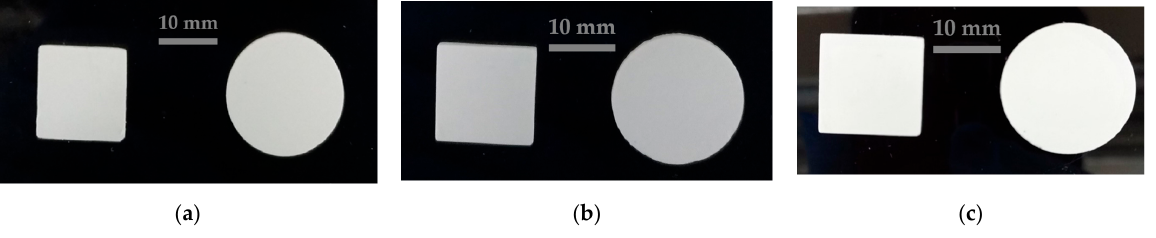
Figure 12. DLP printed part with 25 µm as layer thickness, 50‰ s exposure time, and exposure time of ( a ) 1 s; ( b ) 2 s; ( c ) 3 s, same as Figure 11a. For the discs and plates with layer thicknesses of 50 µm and 100 µm, the samples that were tried to be produced at the lowest level of power and exposure time failed, as the energy input was probably not sufficient for guaranteeing enough light penetration to stick two consecutive layers in a stable way. Other conditions were all printed with dif- ferent outcomes. Since the energy delivered to the layer in the same printing conditions, in terms of exposure time and power, was the same but the volume to which it was deliv- ered was different, the samples with higher layer thickness failed or were mechanically weaker at lower energy input conditions, but survived successfully without heavy distor- tions or deviations at higher energetic conditions. However, due to the fact that for a spec- ified thickness, the number of layers diminishes with the increase of the layer thickness, the 50 µm and, in particular, the 100 µm samples lacked a good interlayer cohesion, re- sulting in samples that had to be handled carefully and were slightly bendable. On the other hand, the 25 µm samples were more compacted and rigid and, thus, achieved a greater density, which was the main objective for producing, in the end, translucent parts. It was interesting to notice that, in general, across all the samples, an increase in the expo- sure time level, rather than an increase in the exposure power level when the same energy dose was delivered, led to better results, suggesting that the management of the exposure time is more significant than the management of exposure power. In fact, the slower en- ergy delivery to the slurry when longer exposure times and lower exposure powers are adopted allows the layers of the green parts to be cured more gradually from the uncured